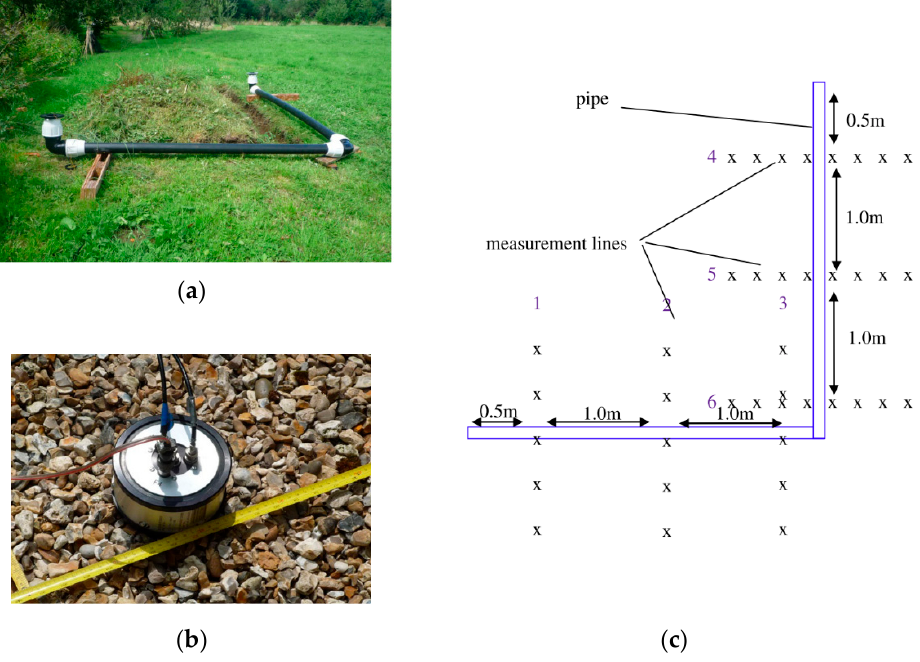
Figure 9. Point vibration measurements: ( a ) pipe rig prior to burial; ( b ) acoustic source (shaker); ( c ) measurement lines (the cross are for illustrative purposes only) [90].